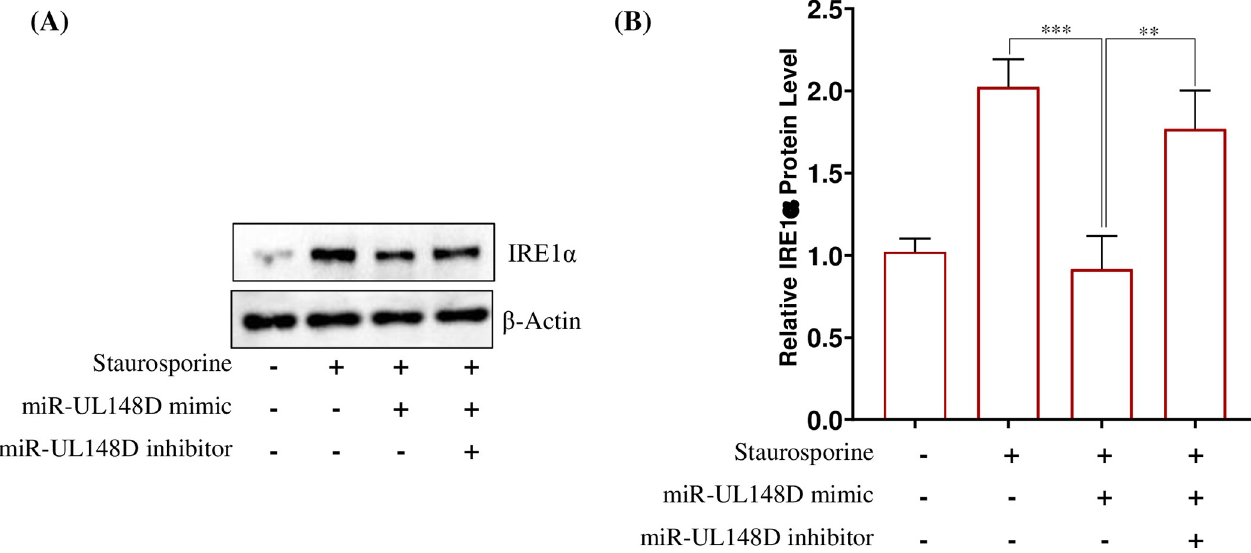
Fig 4. hcmv-miR-UL148D inhibits IRE1 α protein level in staurosporine treated HEK293T cells. (A) The IRE1 α protein levels were analyzed in different groups of cells transfected with hcmv-miR-UL148D, hcmv-miR-UL148D and its inhibitor followed by Staurosporine treatment. The IRE1 α protein and the β - actin levels were examined through western blot. The bands of the blots have been cropped with no further manipulation. (B) Relative IRE1 α protein levels in different groups of cells were quantified through ImageJ software. The IRE1 α levels were normalized to β -actin and plotted as fold change with respect to control. Results represent the mean ± SEM (n = 3 independent experiments) �� p < 0.01; ��� p < 0.001.